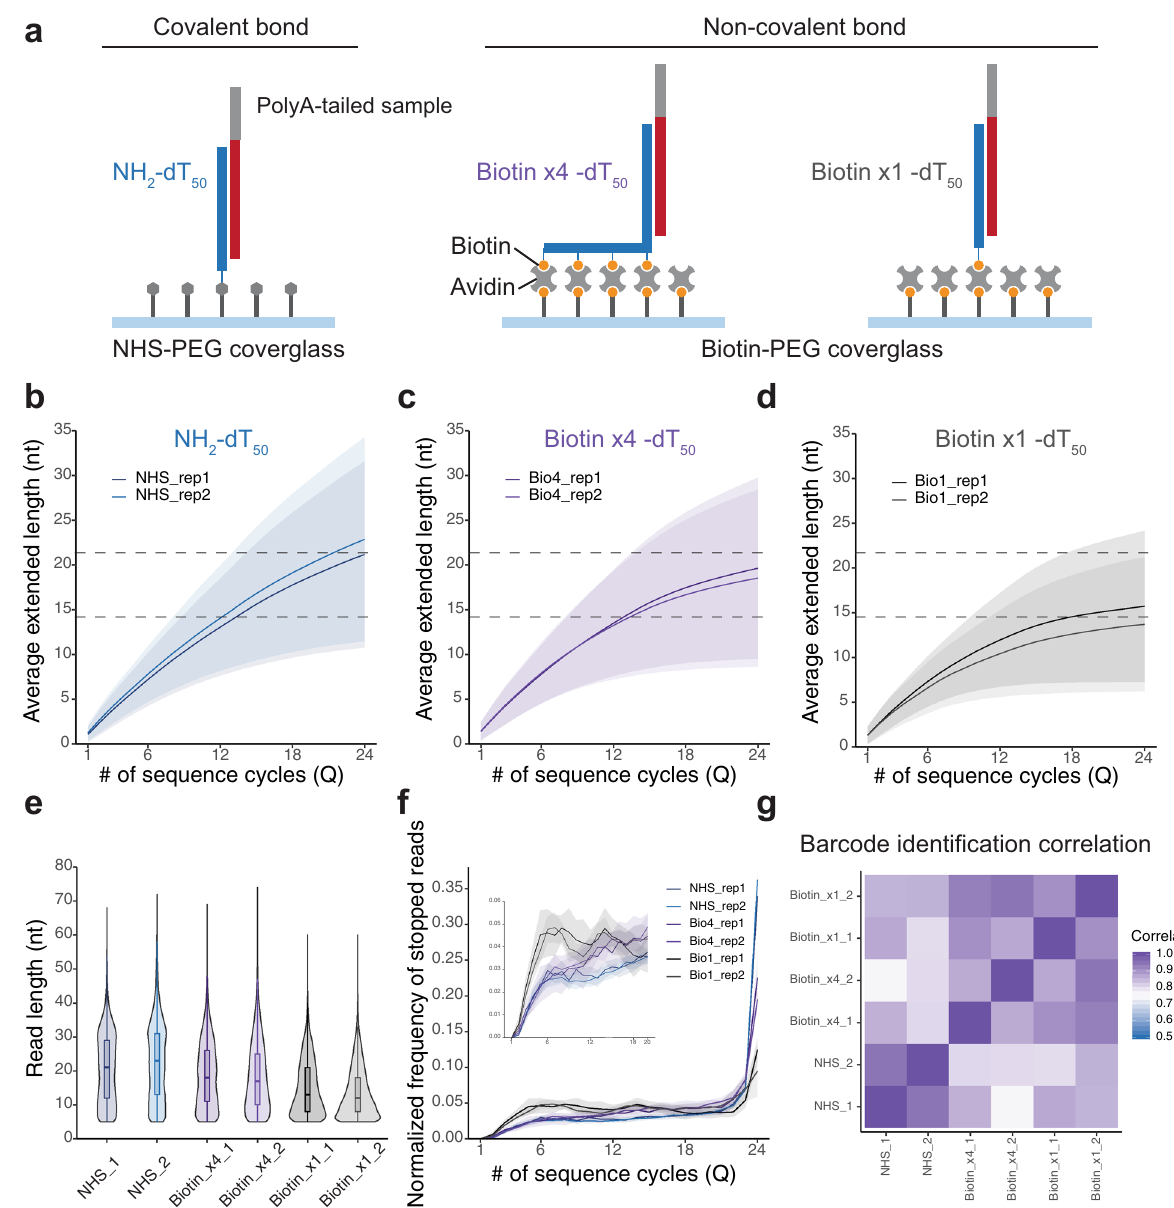
Fig. 3 Impact of anchoring methods used to capture oligos to the fl ow cell on sequence performance. a Schematic illustration of fl ow cells. Three different types of binding between capture probes and a fl ow cell surface were tested as follows; a covalent bond achieved via click chemistry NHS and NH 2 reaction, a non-covalent bond achieved via biotin-avidin but different in the number of biotins per probe, four and one biotin molecules per probe, are shown in the left to the right panels respectively. The same barcode sample shown in Fig. 1 was used for this test. b – d Averaged extension traces for NHS ( b ), biotin × 4 ( c ), and biotin × 1 ( d ), calculated in the same manner shown in Fig. 1f. Colored ribbon plots represent SD at each cycle. All three conditions were repeated twice. e Read length distributions; reads <5 nt were fi ltered out. f Normalized frequency of stopped reads at each cycle. Note that the value at 24Q corresponds to the fraction of reads that reached 24Q (we were unable to identify whether these reads stopped or extended after this point as 24Q was the last cycle). Colored ribbon plots represent SD. g Cross-correlation of the detected count of 30 types of barcodes between